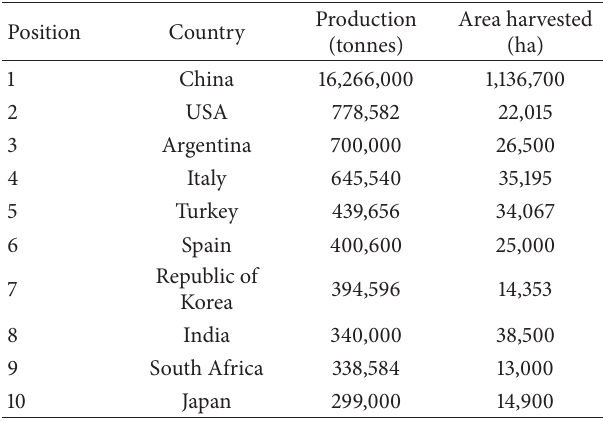
Table5:Worldproductionofpearin2012(tonnes)andthearea(ha) harvested in the ten most productive